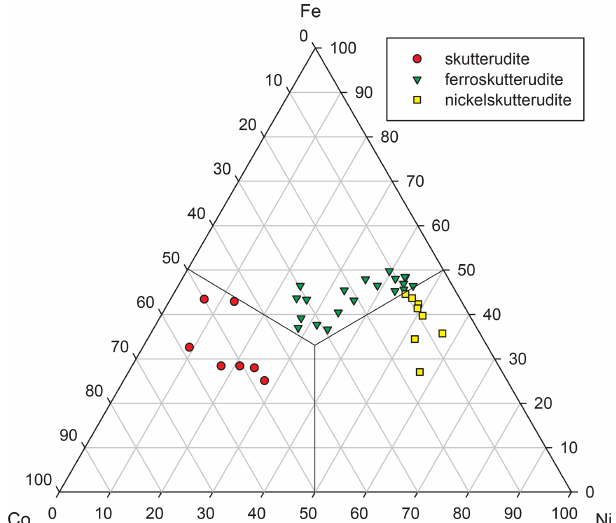
Figure 7. Chemical composition (at. units) for members of the skutterudite subgroup from the grimmite-bearing association from P ˇ ríbram.